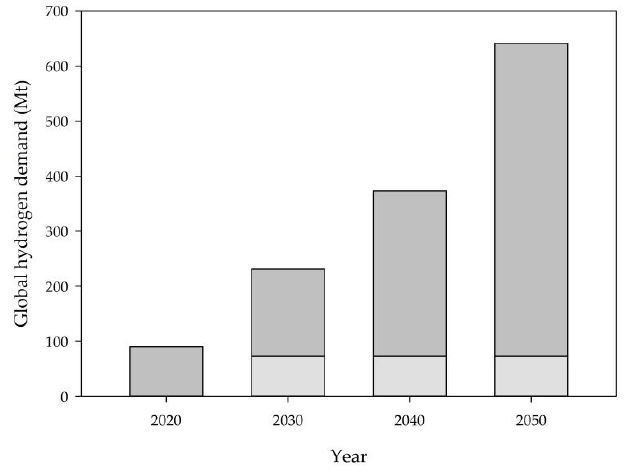
Figure 1. Estimations of the hydrogen demand for the period from 2020 to 2050 ( □ minimum and □ maximum projected demands) (adopted from [13,15]). Table 1. Advantages and disadvantages of hydrogen as a fuel